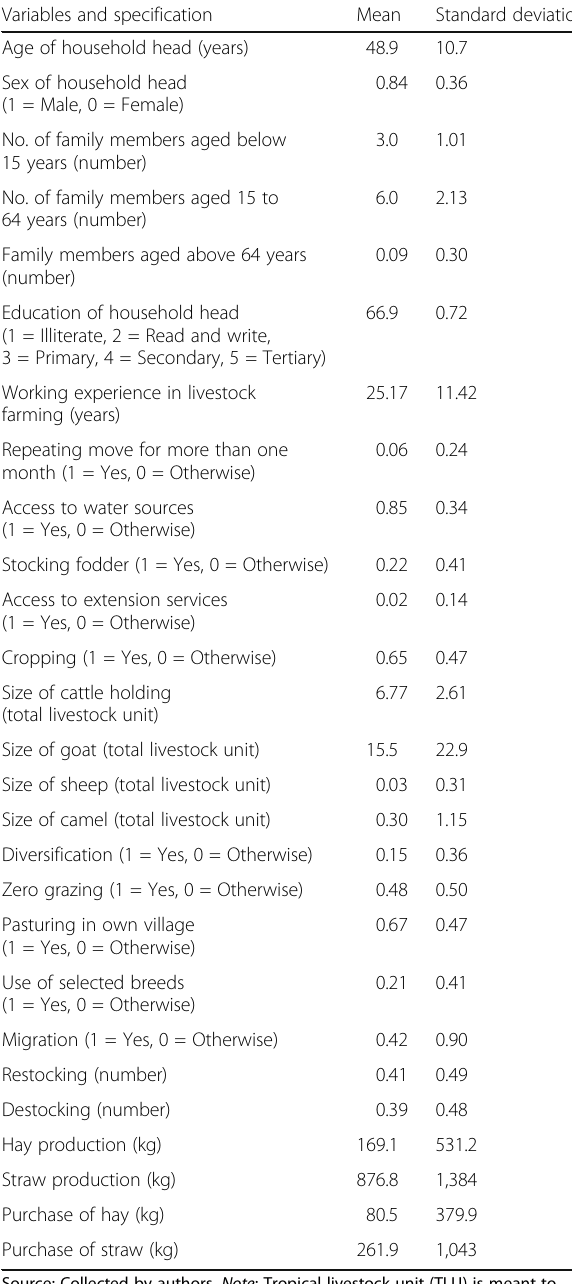
Table 1 Summary statistics and variable descriptions ( n =